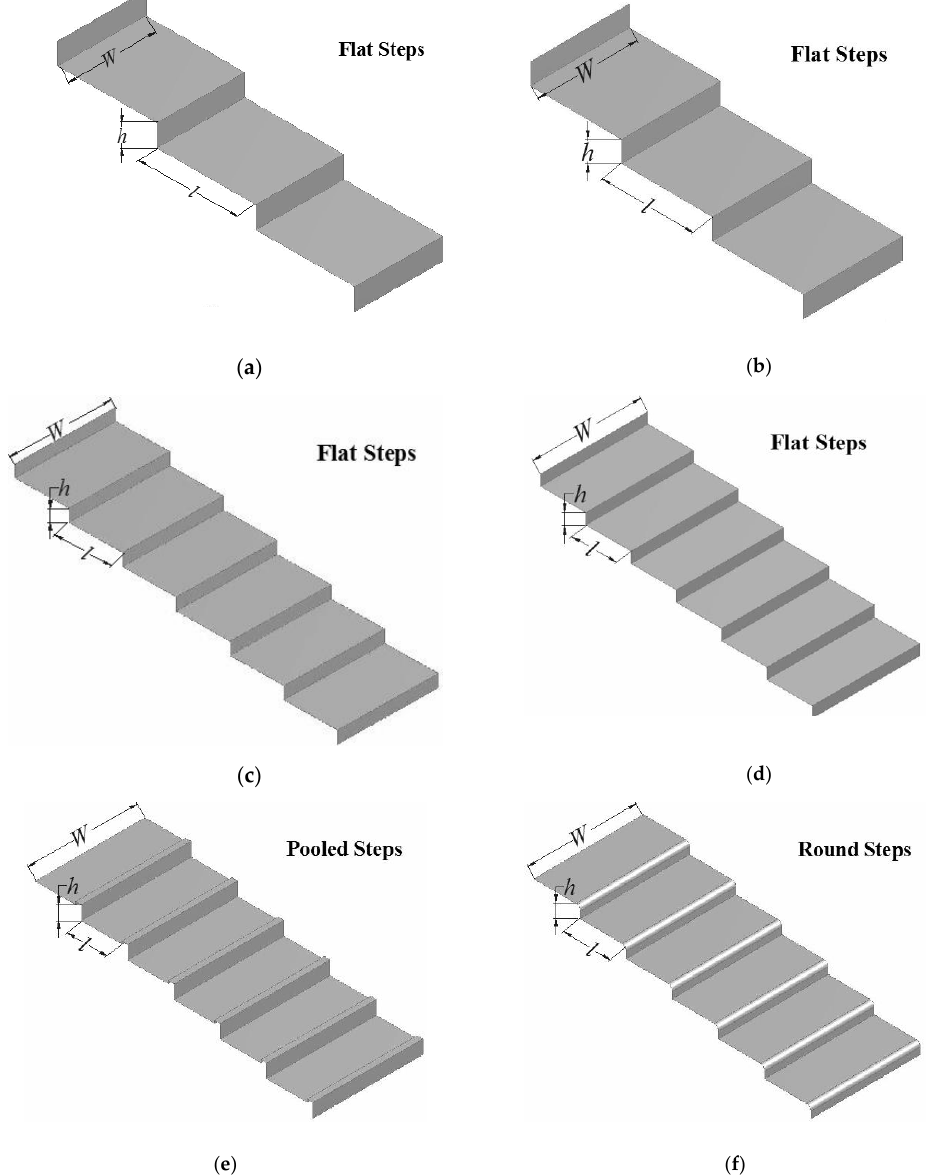
Figure 2. Sketch of stepped spillway configuration: ( a ) M1 with Flat Steps ( h = 0.1 m, l = 0.45 m); ( b ) M2 with flat steps ( h = 0.09 m, l = 0.37 m); ( c ) M3 with flat Steps ( h = 0.05 m, l = 0.21 m); ( d ) M4 with flat steps ( h = 0.04 m, l = 0.17 m); ( e ) M5 with pooled steps; ( f ) M6 with round steps.